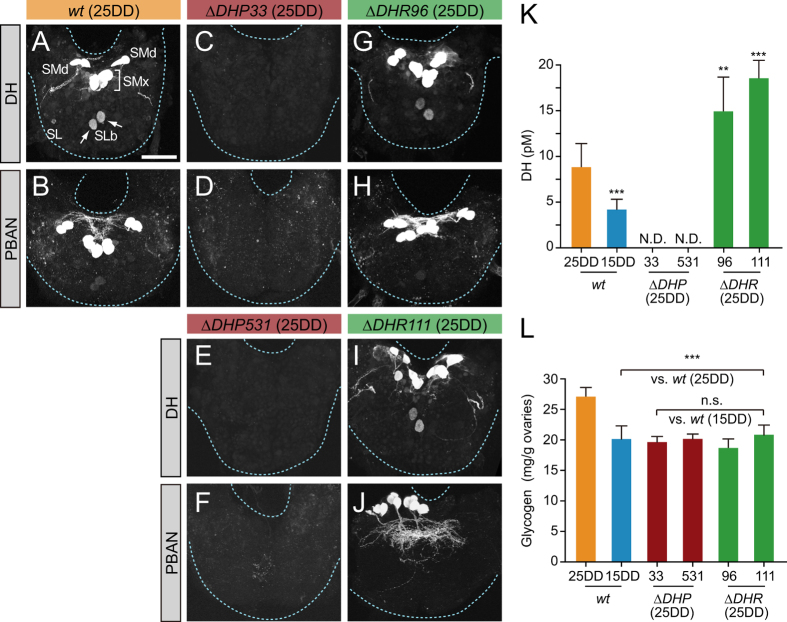
DH and glycogen contents in ΔDHP and ΔDHR mutants.(A–J) Representative images of immunohistochemical staining of pupal subesophageal ganglion (SG) using anti-DH[N] (A,C,E,G,I) and anti-PBAN[N] (B,D,F,H,J). The pupal SG was dissected 4 d after pupation, and immunostaining was performed in the wt (25DD) (A,B), ΔDHP33 (25DD) (C,D), ΔDHP531 (25DD) (E,F), ΔDHP96 (25DD) (G,H), and ΔDHR111 (25DD) (I,J). The DHPC somata (SMd, SMx, SLb, and SL) were detected in wt and ΔDHR. (K) The DH titer in the hemolymph was measured 4 d after pupation, by using TR-FIA. Each bar represents the mean ± SD of 8 samples. N.D., not detected; **P < 0.01; ***P < 0.001 vs. wt (25DD). (L) Glycogen content was measured in ovaries just after eclosion. Each bar represents the mean ± SD of 8 pupae. n.s., not significant vs. wt (15DD); ***P < 0.001 vs. wt (25DD). (Scale bar, 100 μm).